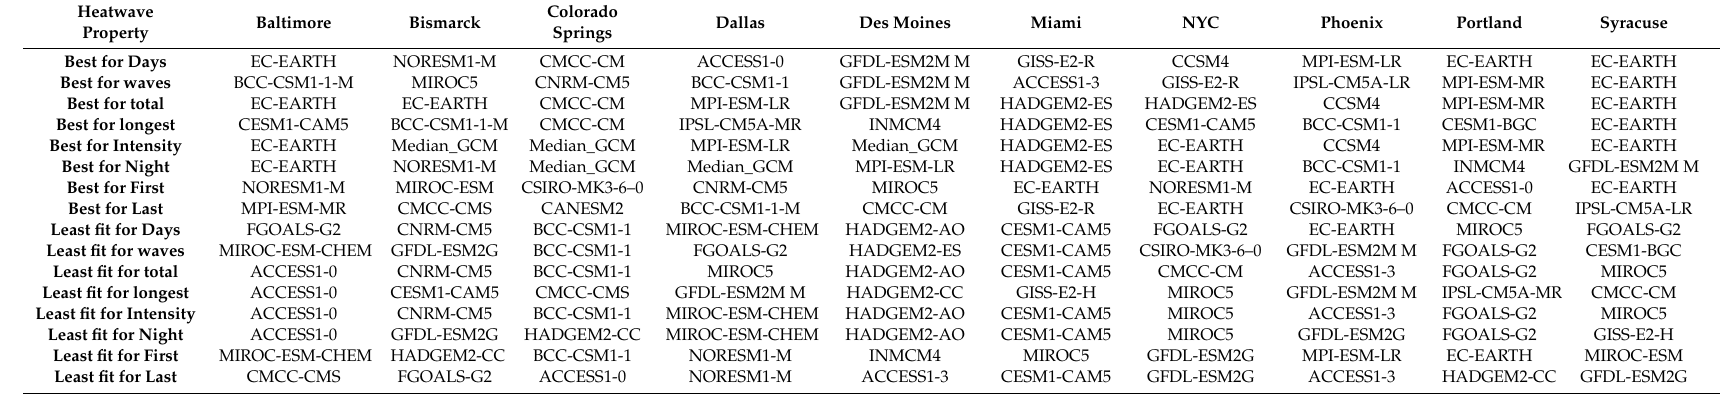
Table 2. Best and Least fit downscaled general circulation models (GCMs) for simulating individual historical heat wave properties in each